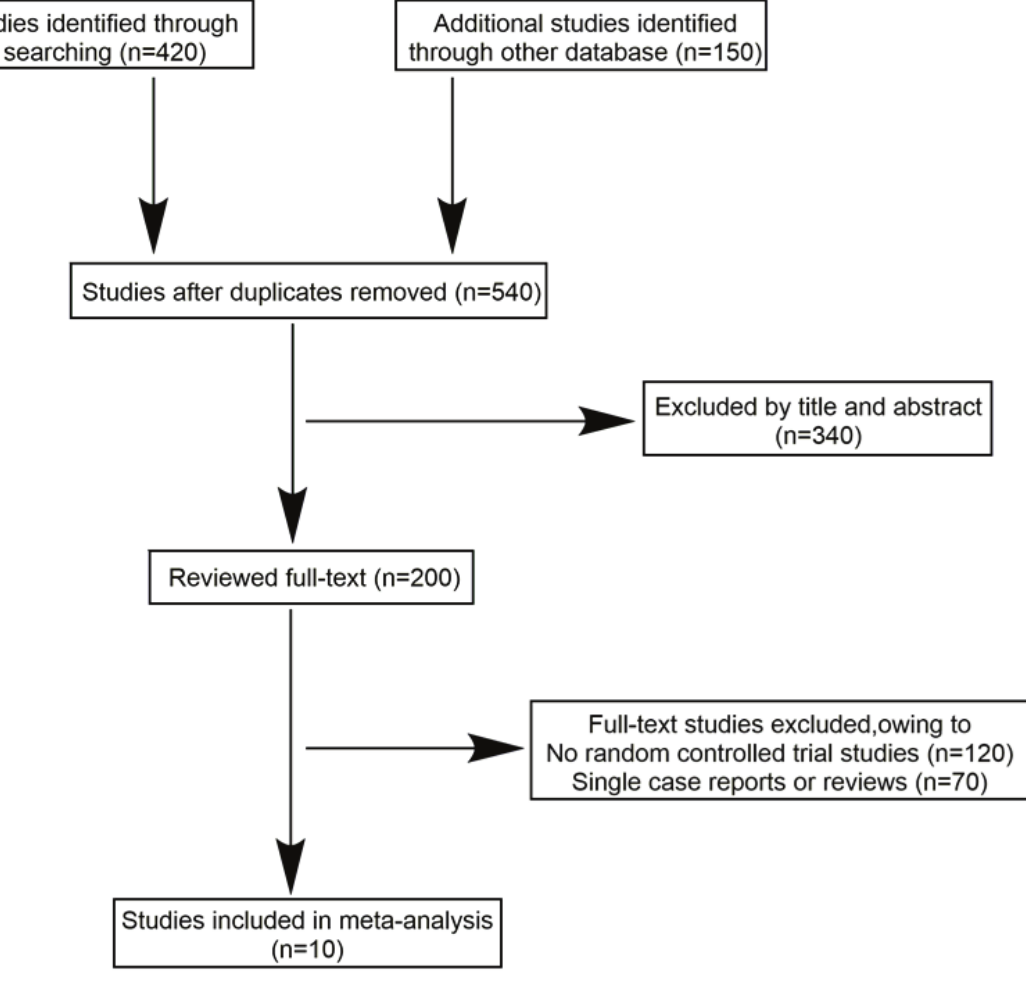
Figure 1: The study selection